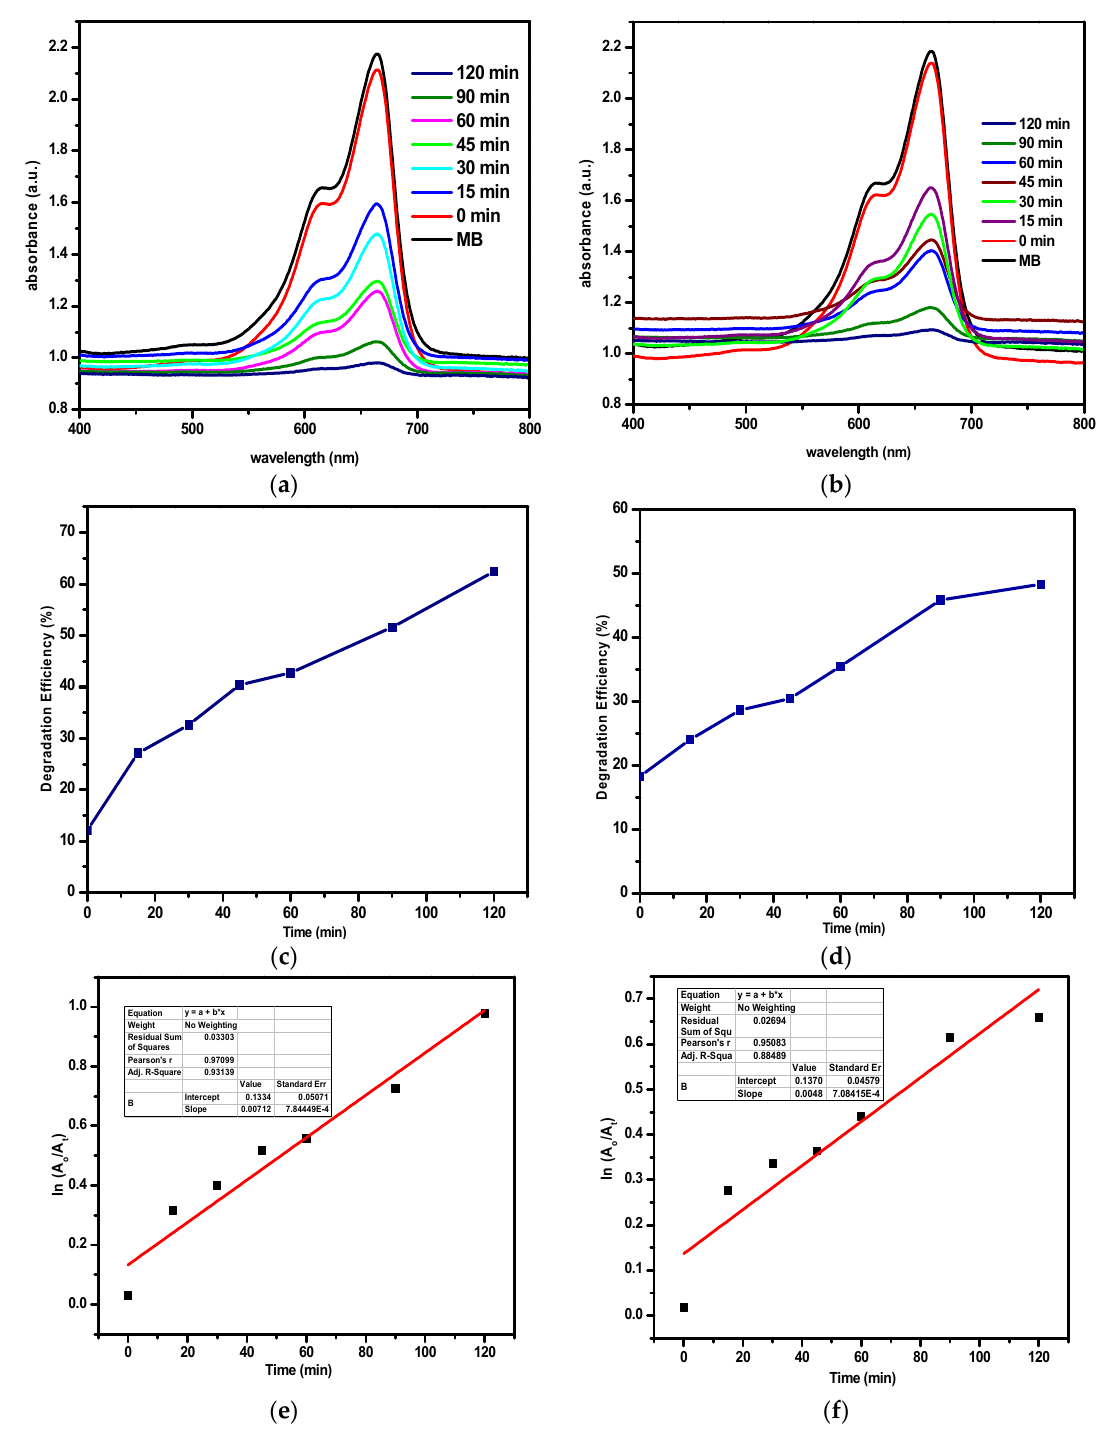
Figure 6. UV–vis spectra of ( a ) SnS 2 and ( b ) SnO 2 nanoparticles regarding the photocatalytic Figure6. UV–visspectraof( a )SnS 2 and( b )SnO 2 nanoparticlesregardingthephotocatalyticdegradation degradation of MB; degradation efficiency in percentages of ( c ) SnS 2 ( d ) SnO 2 ; plot of ln A o /A t against of MB; degradation e ffi ciency in percentages of ( c ) SnS 2 ( d ) SnO 2 ; plot of ln A o / A t against time showing time showing the first order kinetics of ( e ) SnS 2 ( f ) SnO 2 . the first order kinetics of ( e ) SnS 2 ( f ) SnO 2